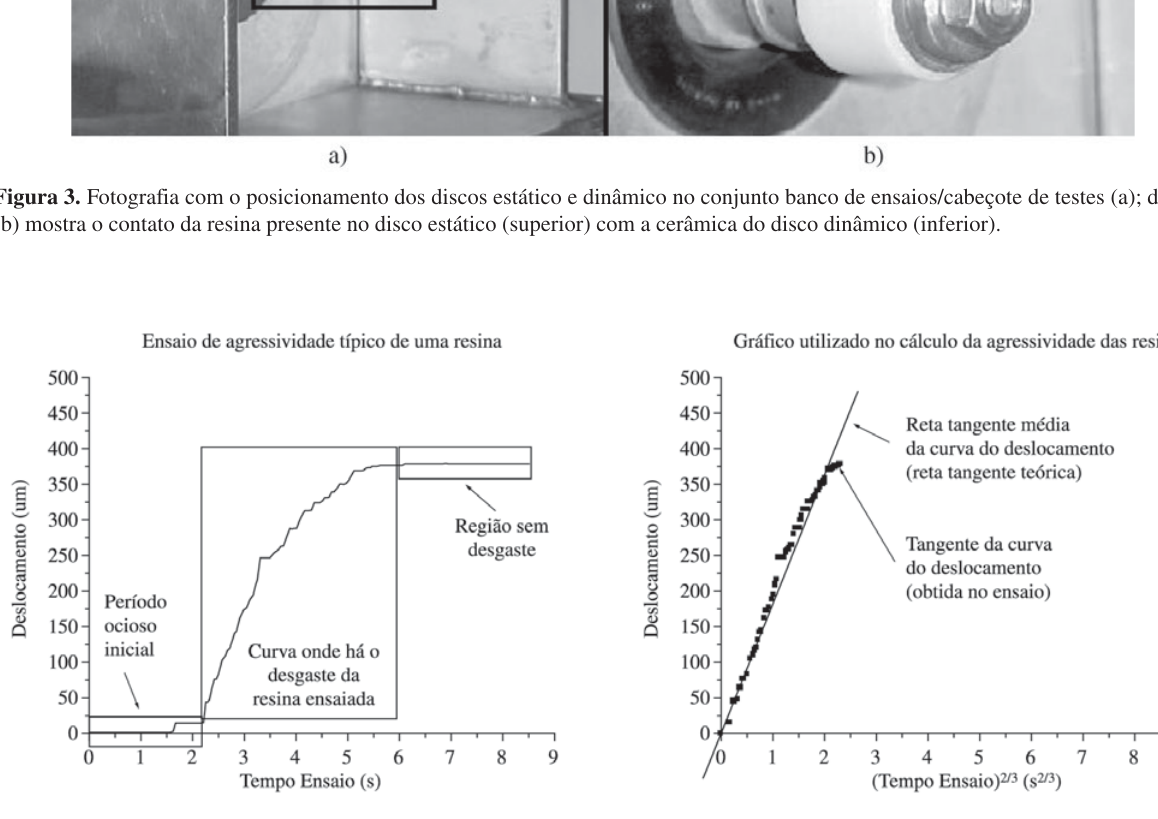
Figura 4. Gráfico típico de deslocamento do dispositivo em função do tempo, obtido nos ensaios de agressividade das resinas